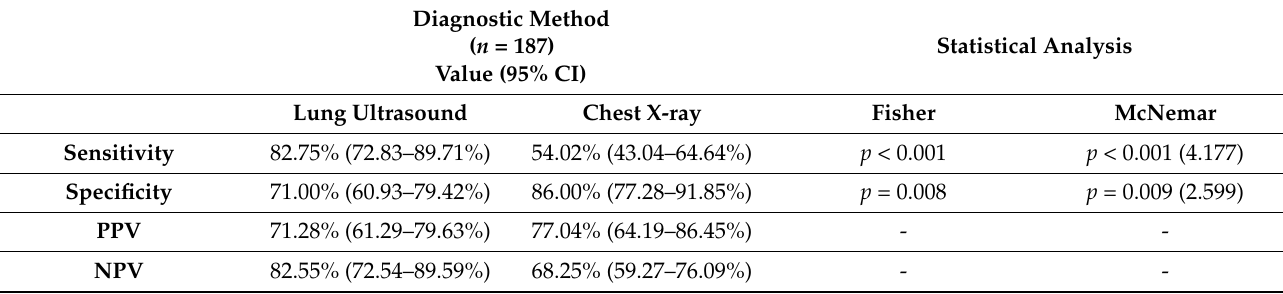
Table 4. Comparative study of the lung ultrasound and chest X-ray in early detection of COVID-19-related interstitial